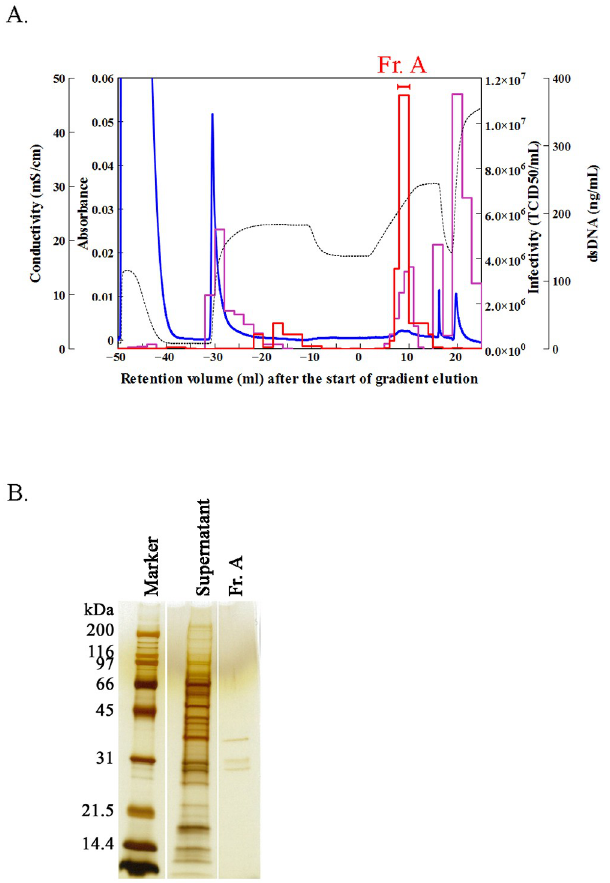
Fig 2. Purification of Sabin type 2 virus by pH gradient elution on a ceramic fluoroapatite (CFAp) column. (A) Chromatogram obtained under the following conditions: column, CFAp; sample (volume), cell culture supernatant containing Sabin type 2 virus (5 mL); column wash, 10 mM sodium phosphate buffer (NaPB; pH 6.4, 10 mL) and 300 mM NaPB (pH 6.4, 20 mL); equilibration, 300 mM NaPB (pH 5, 15 mL); elution, linear gradient at 300 mM NaPB from pH 5 to pH 8.2 for 10 mL; wash after separation, 300 mM NaPB (pH 8.2, 5 mL) and 600 mM NaPB (pH 8.2, 10 mL). Blue line, ultraviolet (UV) absorbance at 280 nm; black broken line, conductivity; red line, infectivity in median tissue culture infectious dose (TCID 50 ); and purple line, double-stranded DNA (dsDNA) contents. Fr. A was pooled for the evaluation. (B) Sodium dodecyl sulfate–polyacrylamide gel electrophoresis (SDS–PAGE) analysis. The cell culture supernatant and pooled Fr. A were concentrated 10-fold and 30-fold, respectively, by ultrafiltration using a molecular weight cutoff of 10,000. The molecular weights of the marker proteins are given in kDa.